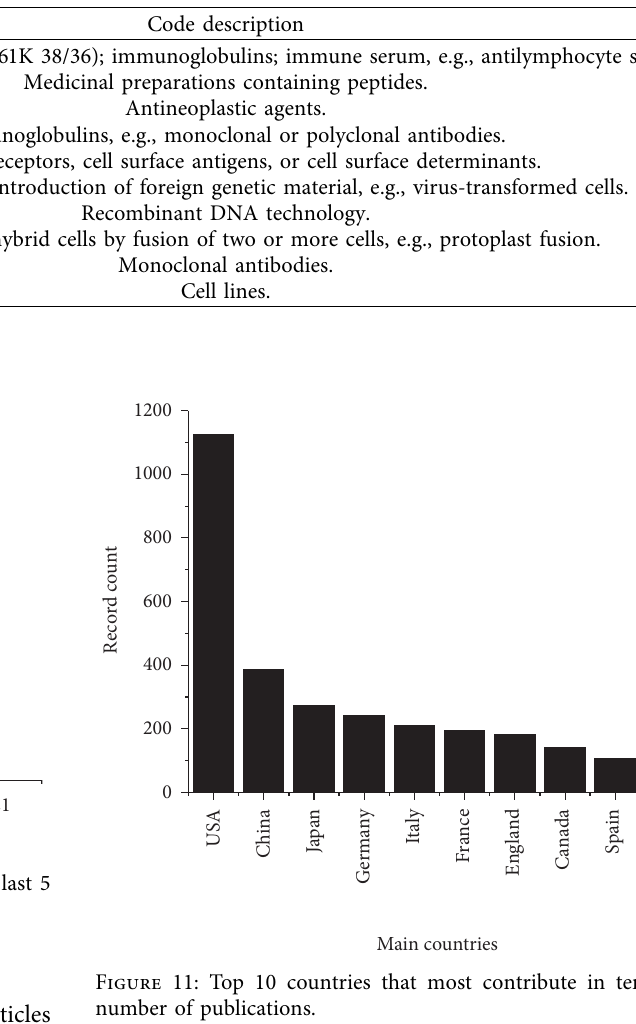
Table 2: International Patent Classification (IPC) established by the WIPO, found in prospective patent documents.